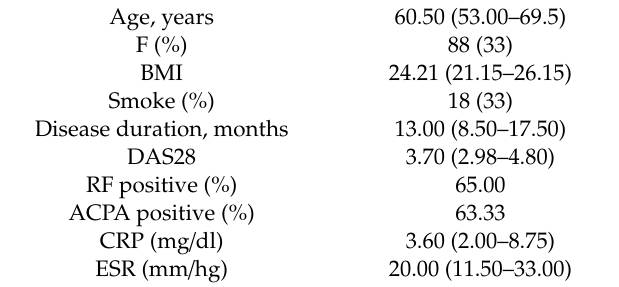
Table 1. Main demographic, anthropometric, and clinical